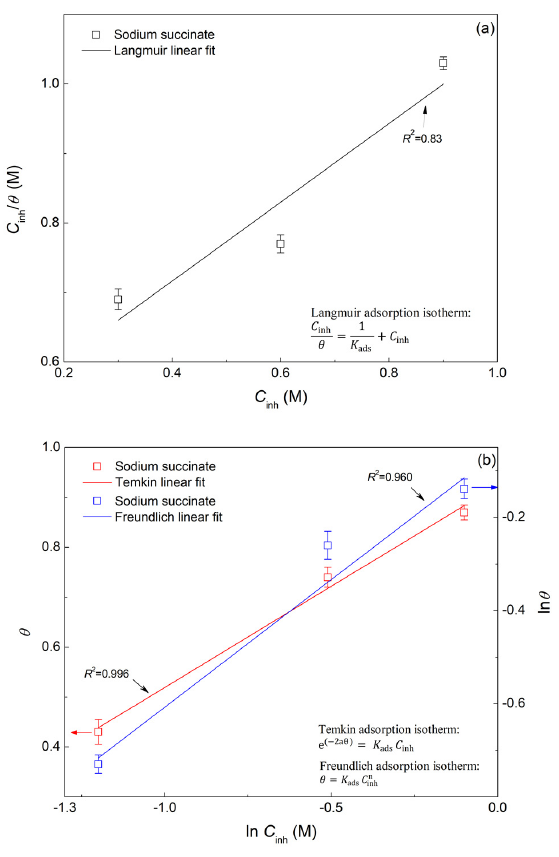
Figure 11. Fittings of different adsorption isotherms for carbon steel in the presence of sodium succinate in 0.6 M Cl − SCPS at 25 °C. ( a ) Langmuir adsorption isotherm, and ( b ) Temkin and Freundlich adsorption isotherms.